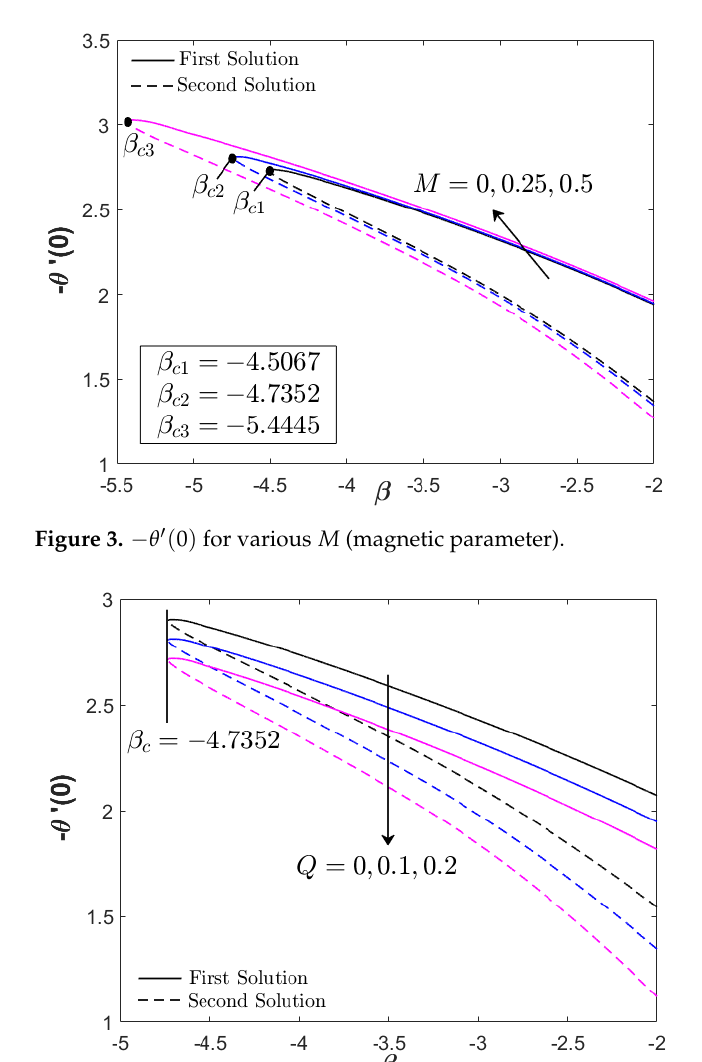
( ) 0 θ′− for various Q (heat generation parameter). Figure 4. Figure 4. − θ (cid:48) ( 0 ) for various Q (heat generation